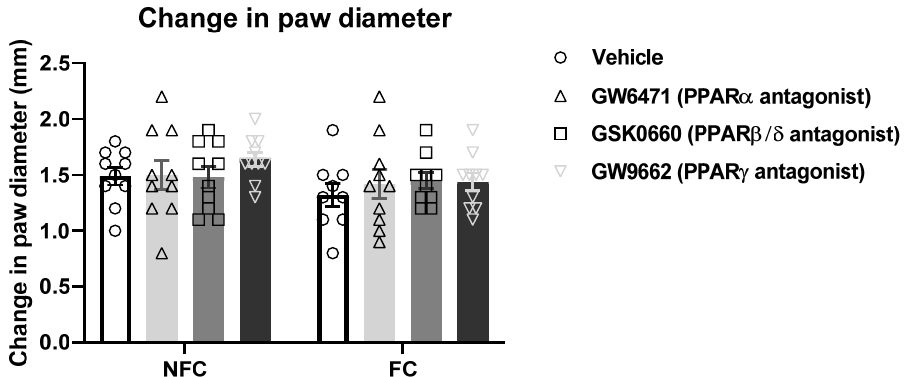
Figure 9. Effects of intra-BLA administration of selective PPAR α , PPAR β / δ , and PPAR γ antagonists on saline-evoked changes in the hind paw diameter in non-fear conditioned (NFC) and fear condi- tioned (FC) rats. The change was assessed by measuring the paw diameter immediately before, and 60 min after, saline administration. Data are expressed as mean ± S.E.M, each symbol represents one individual, n = 8–10 rats per group.